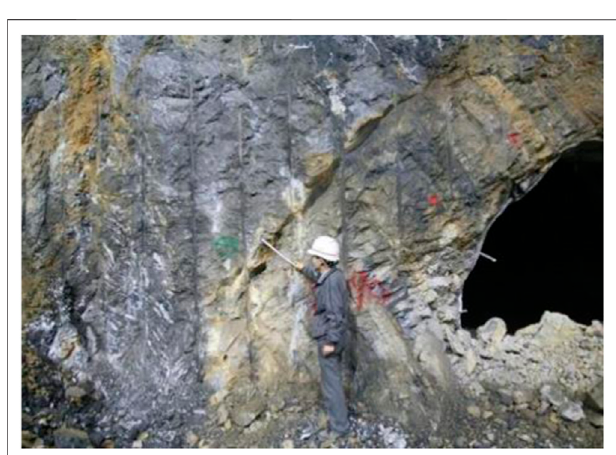
FIGURE 3 | f 42 fault in the main powerhouse of the right